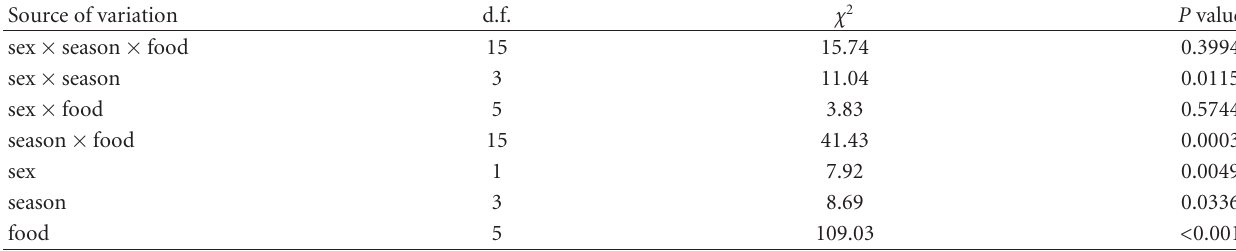
Table 2: Log-linear model for frequency of occurrence of prey items in the stone marten diet in Central Greece, during 2003–2006. Source of variation